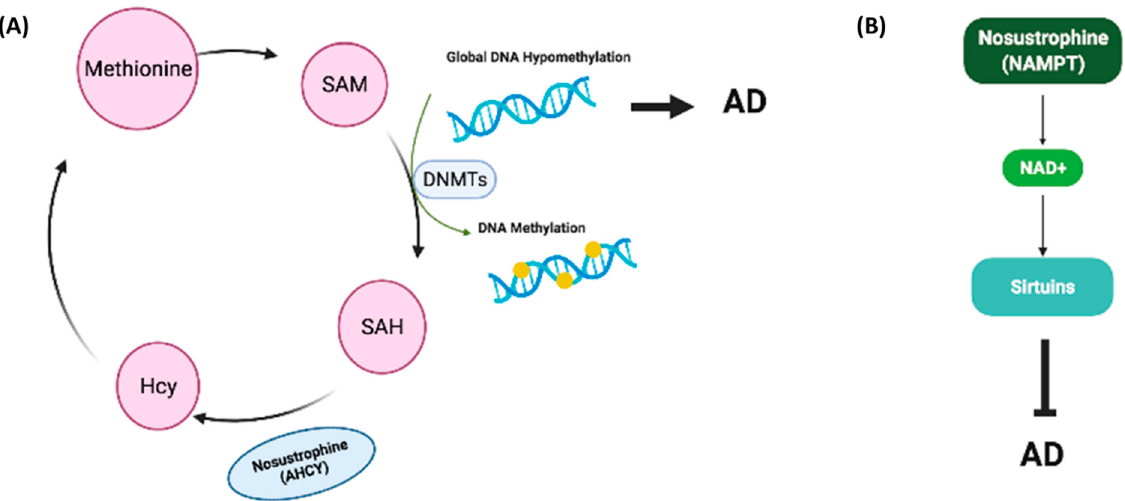
Figure 13. Proposed working models for Nosustrophine as an epinutraceutical bioproduct with therapeutic potential against AD. ( A ) The primary methyl donor for DNA and histone methylation reactions is SAM. DNMTs convert SAM into SAH. AHCY in Nosustrophine interacts with and increases the activity of DNMT1, promoting the conversion of SAM into SAH. SAH is subsequently hydrolyzed by AHCY into Hcy. AHCY also increases de novo DNA methylation via DNMT1 activation; global DNA hypomethylation facilitates AD pathogenesis. ( B ) NAMPT, a rate-limiting enzyme that catalyzes the first step in NAD+ production, was detected in Nosustrophine. NAMPT overexpression elevates NAD+ levels, which stimulate SIRT1 expression, increases cerebral blood flow and improves cognitive function in AD. The presence of NAMPT in Nosustrophine may account for the increase in SIRT1 expression in Nosustrophine-treated older (8–9-month-old) 3xTg-AD mice. 3xTg-AD, triple-transgenic mouse model of AD; AD, Alzheimer’s disease; AHCY, adenosylhomocysteinase; DNMT, DNA methyltransferase; Hcy, homocysteine; NAD+, nicotinamide adenine dinucleotide; NAMPT, nicotinamide phosphoribosyltransferase; SAH, S-adenosylhomocysteine; SAM, S-adenosylmethionine; SIRT1, Sirtuin 1. EGb 761 improves cognitive function in patients with mild-to-moderate dementia and in individuals with mild cognitive impairment [87]. EGb 761 protects against β -amy- loid-induced neurotoxicity in the N2a neuroblastoma cell line through SIRT1 activation [88]. Administration of polyphenols to APP/PS1 mice increases SIRT1 expression in the brain, blocks the aggregation of tau, modulates APP processing, and reduces memory def- icits [85]. Resveratrol activates SIRT1, disrupting β -amyloid aggregation and clearing se- nile plaques [89]. In the present study, Nosustrophine did not alter SIRT activity. Since the SIRT activity assay used in the current study measures global SIRT activity, it is pos- sible that only SIRT1 activity increased and not the activities of other SIRTs. However, qPCR showed that Nosustrophine increased SIRT1 mRNA levels in both wild-type and APP/BIN1/COPS5 AD mice. This increase was higher in Nosustrophine-treated APP/BIN1/COPS5 mice than in saline-treated transgenic animals; however, this difference